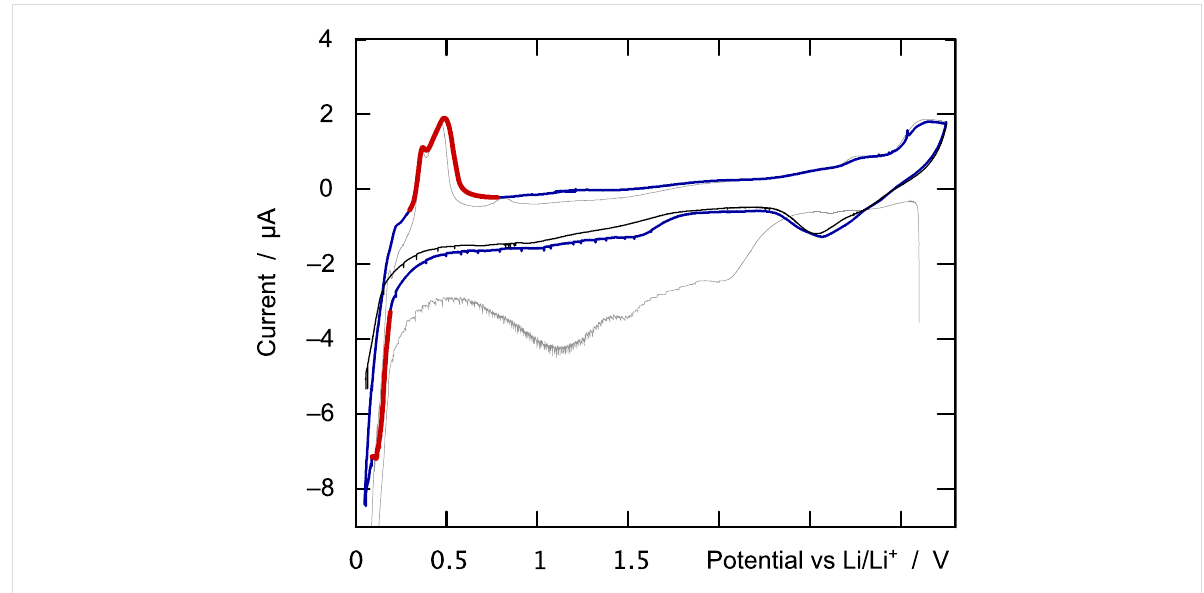
Figure 7: Cyclic voltammetry recorded on a silicon nanotube sample at 0.1 mV s − 1 in 1 mol L − 1 LiPF 6 in ethylene carbonate/dimethylcarbonate by using metallic lithium as the auxiliary electrode and pseudo-reference. The scans were performed between +3.25 V and +0.05 V. The first cycle is plotted as a thin gray line, the second cycle in blue and red, and the third charge in black. The red color highlights the main reduction (charge) and oxidation (discharge) events of the